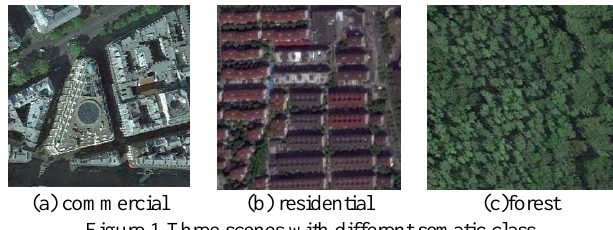
Figure 1 Three scenes with different sematic